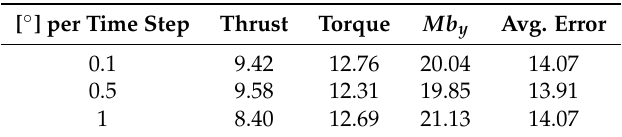
Figure 4. Comparison of azimuthal dependency of integral quantities, for time convergence. Table 2. Comparison of the relative error for integral quantities, for time convergence analysis. Values are presented in percentage [%] unless indicated